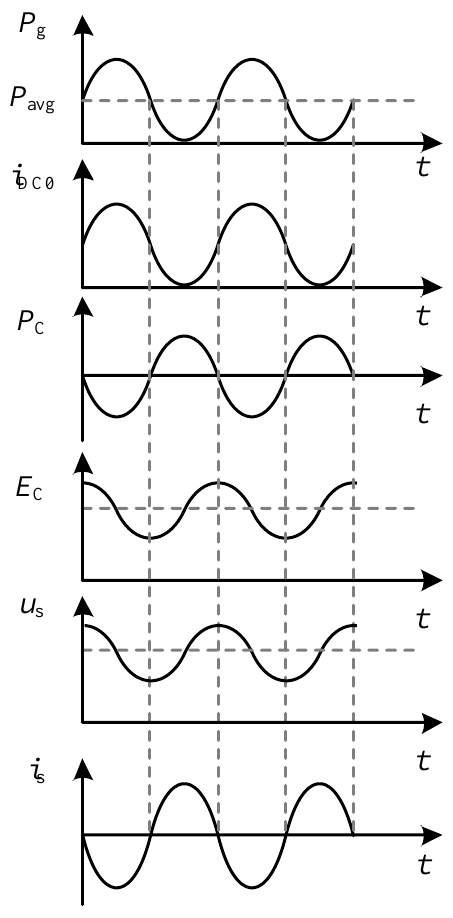
Figure 8. The ideal power decoupling performance of the integrated buck/boost stage.